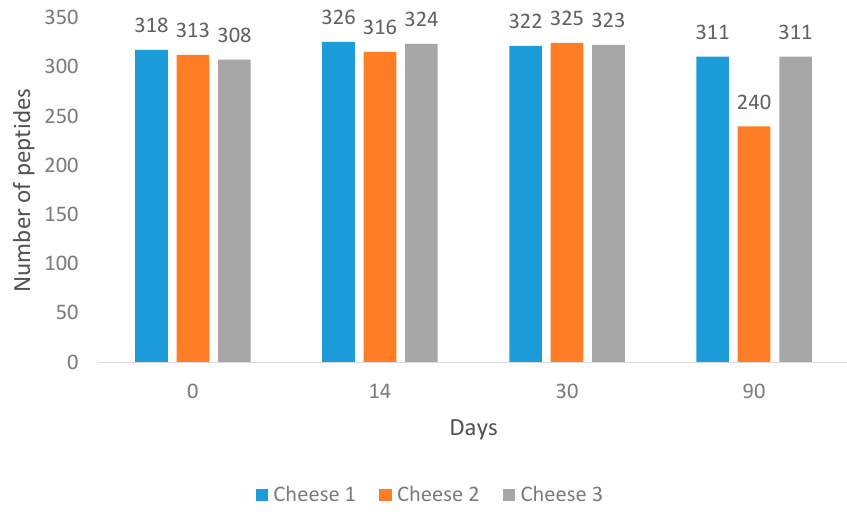
Figure 1. Number of identified peptides with unique amino acid sequences across 90 days of ripening.